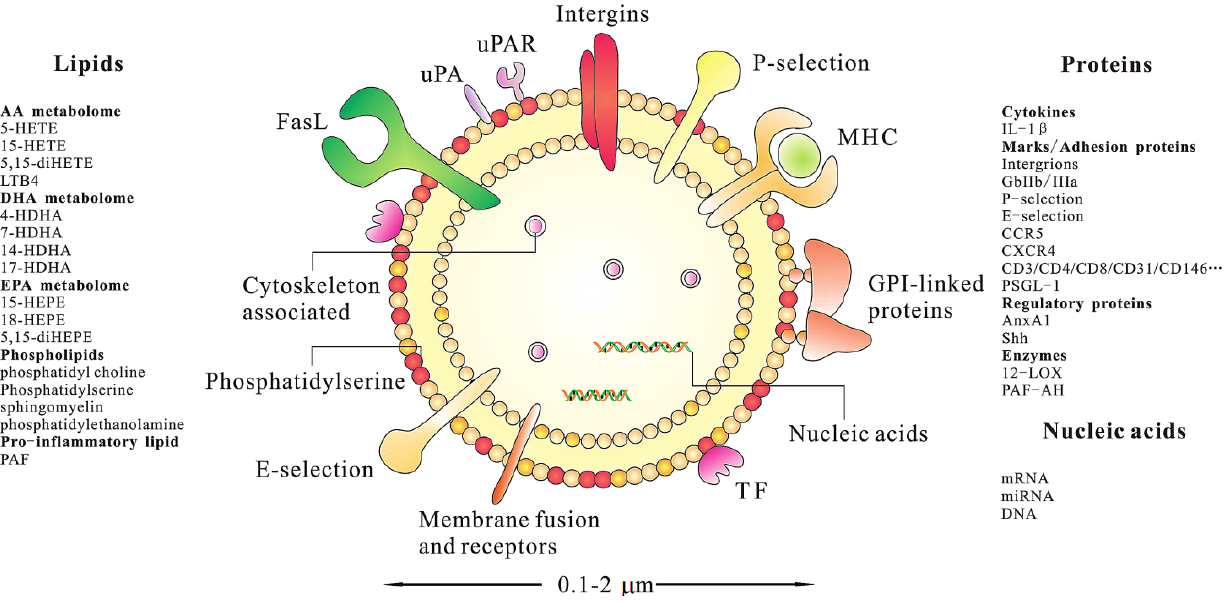
Figure 1. Schematic illustration of a cell-derived microparticle (MP). These biomolecules are identified from diverse research publications. This presentation does not intend to be exhaustive with respect to the different components of MPs. IL-1 β , interleukin-1 β ; GPI, glycosylphosphatidylinositol; GPIIb/IIIa, glycoprotein IIb/IIIa; CCR5, C–C chemokine receptor type 5; CXCR4, C–X–C chemokine receptor type 4; PSGL-1, P-selectin glycoprotein ligand-1; AnxA1, Annexin A1; Shh, Sonic Hedgehog; 12-LOX, 12-lipoxygenase; PAF-AH, platelet-activating factor acetylhydrolase; HETE, hydroxy-eicosatetraenoic acid; LTB4, leukotriene B4; HDHA, hydroxy-docosahexaenoic acid; HEPE,